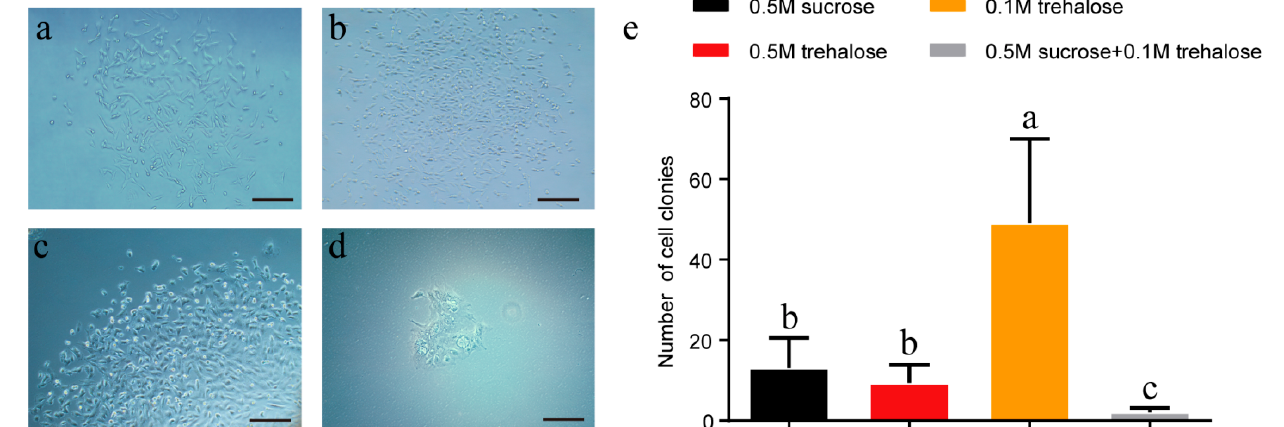
Figure 3. Effects of trehalose on the vitrification of ear tissues. ( a ) Cell derivation from tissues frozen using vitrification solution with 0.5 M sucrose; ( b ) Cell derivation from tissues frozen using vitrification solution with 0.5 M trehalose; ( c ) Cell derivation from tissues frozen using vitrification solution with 0.1 M trehalose; ( d ) Cell derivation from tissues frozen using vitrification solution with 0.5 M trehalose and 0.1 M trehalose; ( e ) Numbers of cell colonies with different vitrification solutions. Error bars represent the SEM. Scale bar = 200 µm.